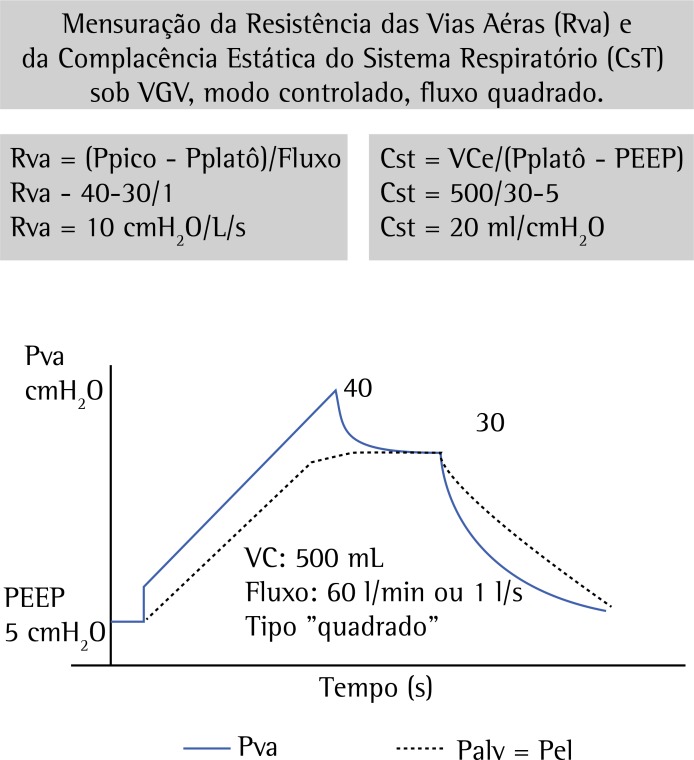
Manobra de pausa inspiratória e obtenção da resistência das vias
aéreas e pressão de pausa (ou platô). VCV - volume controlado. Pva -
pressão nas vias aéreas; PEEP - pressão expiratória final positiva; VC -
volume corrente; Pel - pressão elástica; Palv - pressão alveolar.